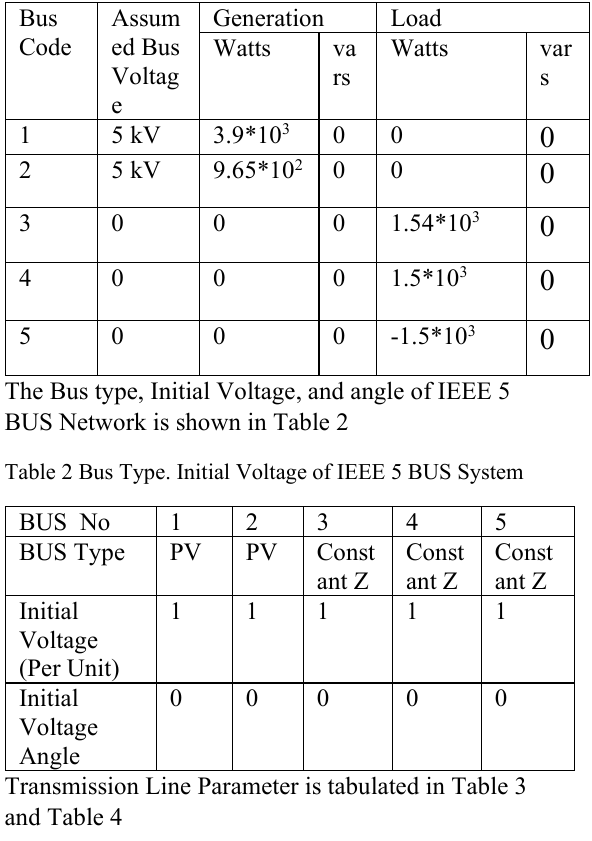
Table 1 Parameters in IEEE 5 BUS System